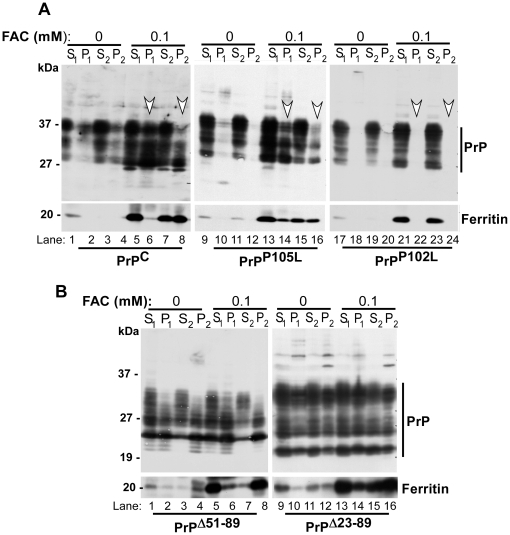
Exogenous redox-iron induces aggregation of PrPC and certain mutant PrP forms.(A and B) Control and FAC exposed lysates from PrPC, PrP105L, PrP102L, PrPΔ51-89, and PrPΔ23-89 cells were subjected to differential centrifugation, and fractionated proteins were probed for PrP and ferritin. A significant amount of PrPC and PrP105L partition in the detergent insoluble P1 and P2 fractions following exposure to FAC (panel A, lanes 1–4 vs. 5–8 and lanes 9–12 vs. 13–16), while PrP102L partitions mainly in the detergent soluble S1 and S2 fractions (panel A, lanes 17–24), and PrPΔ51-89 and PrPΔ23-89 partition equally between soluble (S1, S2) and insoluble (P1, P2) fractions (panel B, lanes 1–16) in the absence or presence of FAC.